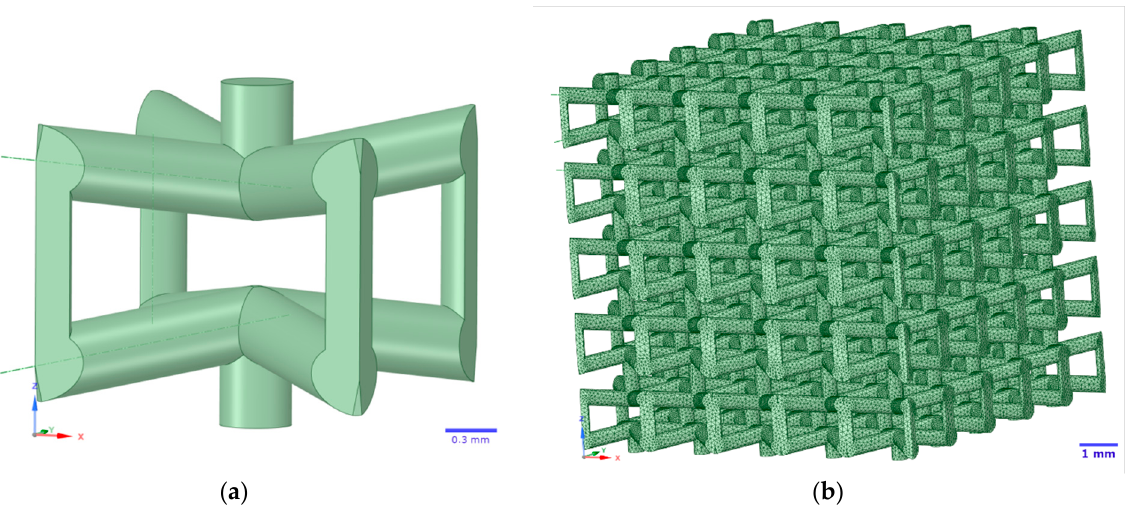
Figure 3. ( a ) Single Type5 unit cell with negative Poisson’s ratio; ( b ) Lattice structure based on a single Type 5 unit cell.